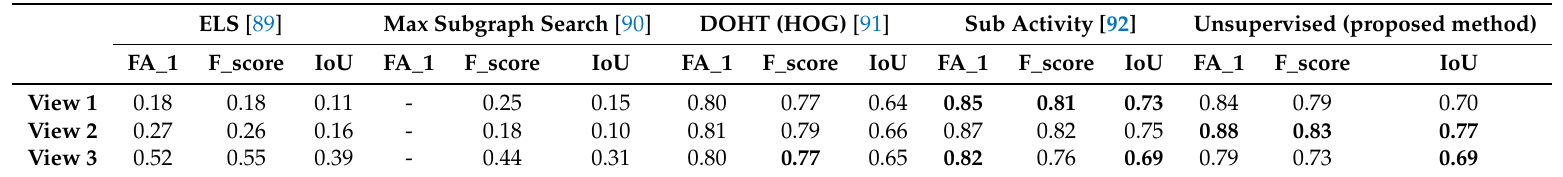
Table 5. The activity detection results obtained on the DAHLIA. Values in bold represent the best